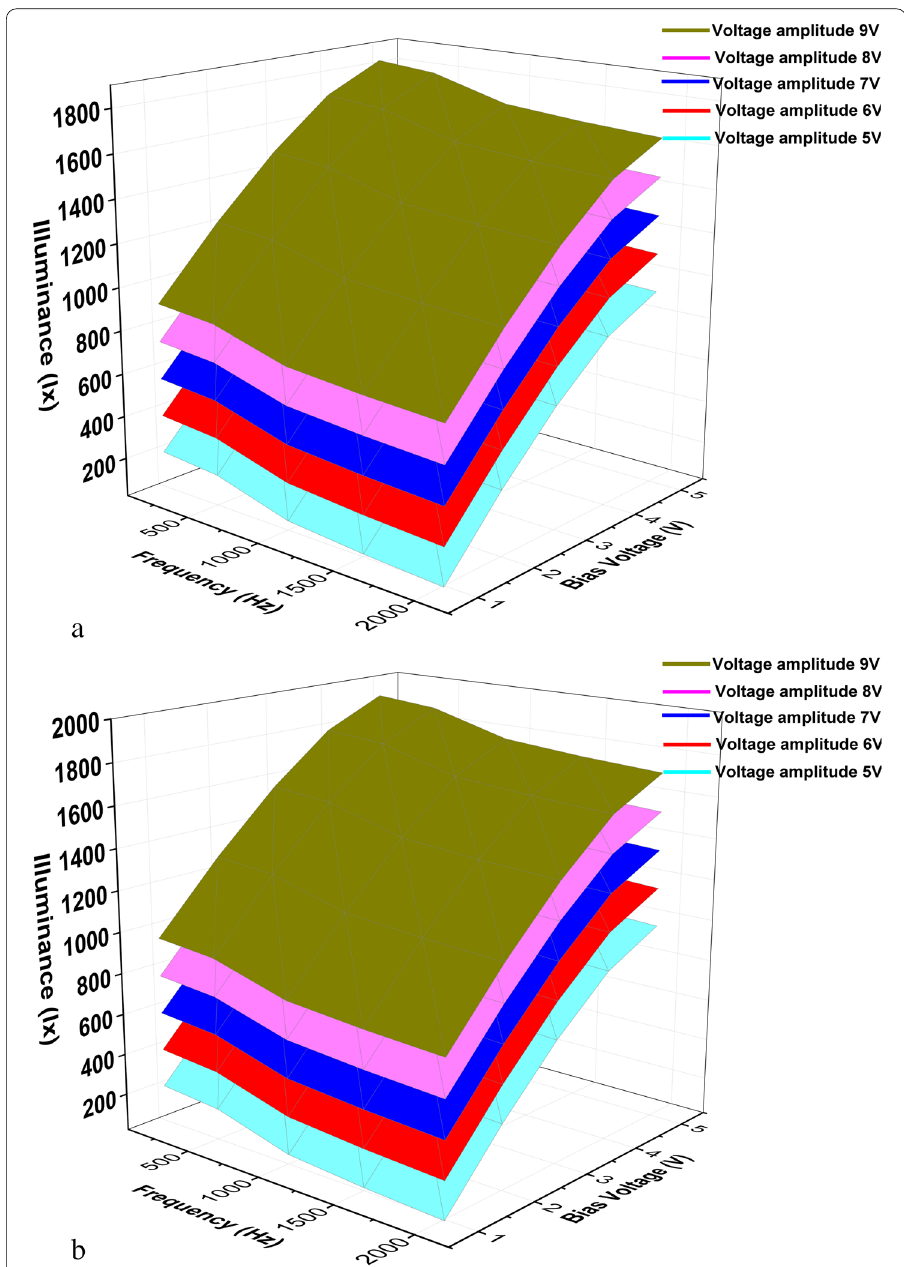
Fig. 11 a Calculated illuminance of the mixed white LED source with frequency, bias voltage, and voltage amplitude. b Measured illuminance of the mixed white LED source with frequency, bias voltage, and voltage